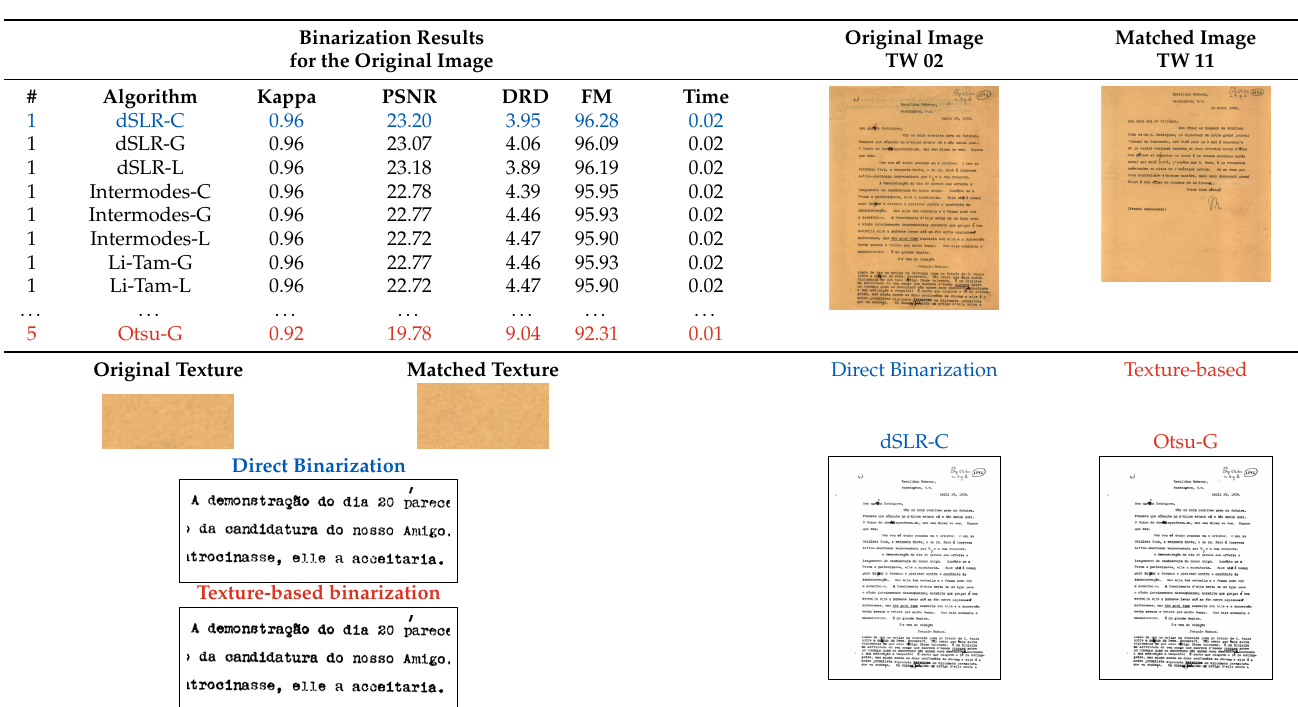
Table 11. Results for image matching with image TW